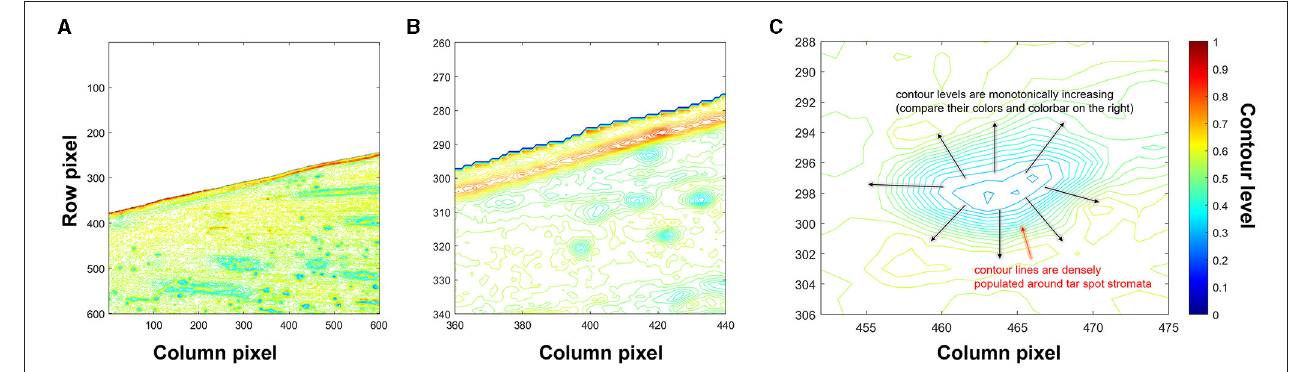
FIGURE 4 | Contour lines generated from a normalized grayscale image block. (A) All contour lines, (B) zoomed-in view of contour lines where columns from 360 to 440 and rows from 260 to 340, and (C) distinct pattern of contour lines of stromata.